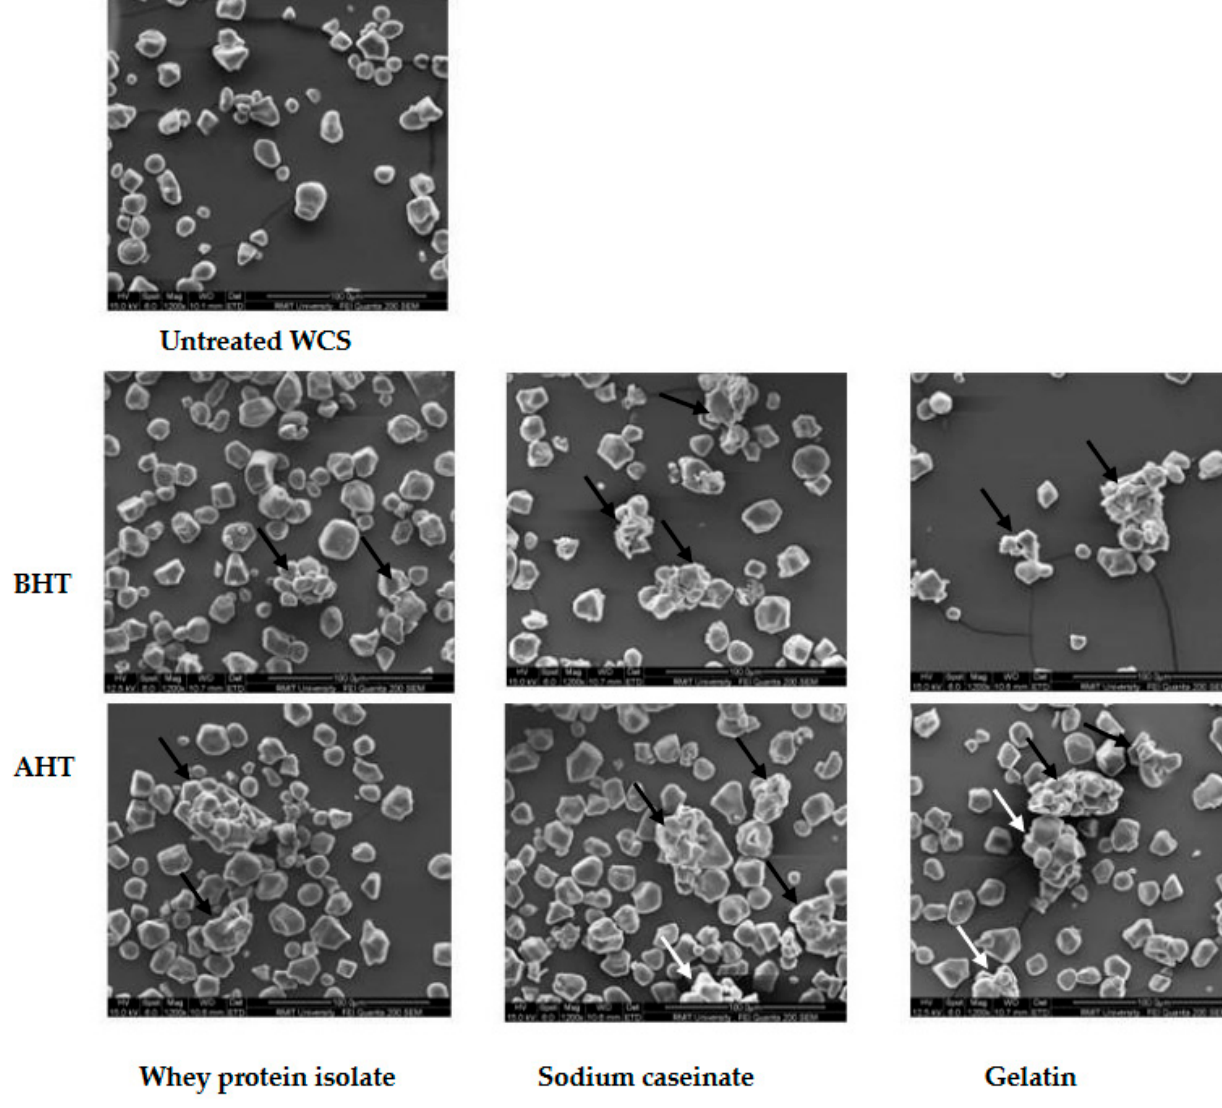
Figure 5. Scanning electron micrographs captured for the untreated waxy corn starch (WCS) and in combination with proteins prepared by the wet mixing method before and after dry heat treatment under 1000 × SEM. Arrows on the micrographs show that the protein coated the aggregated gran- ules.